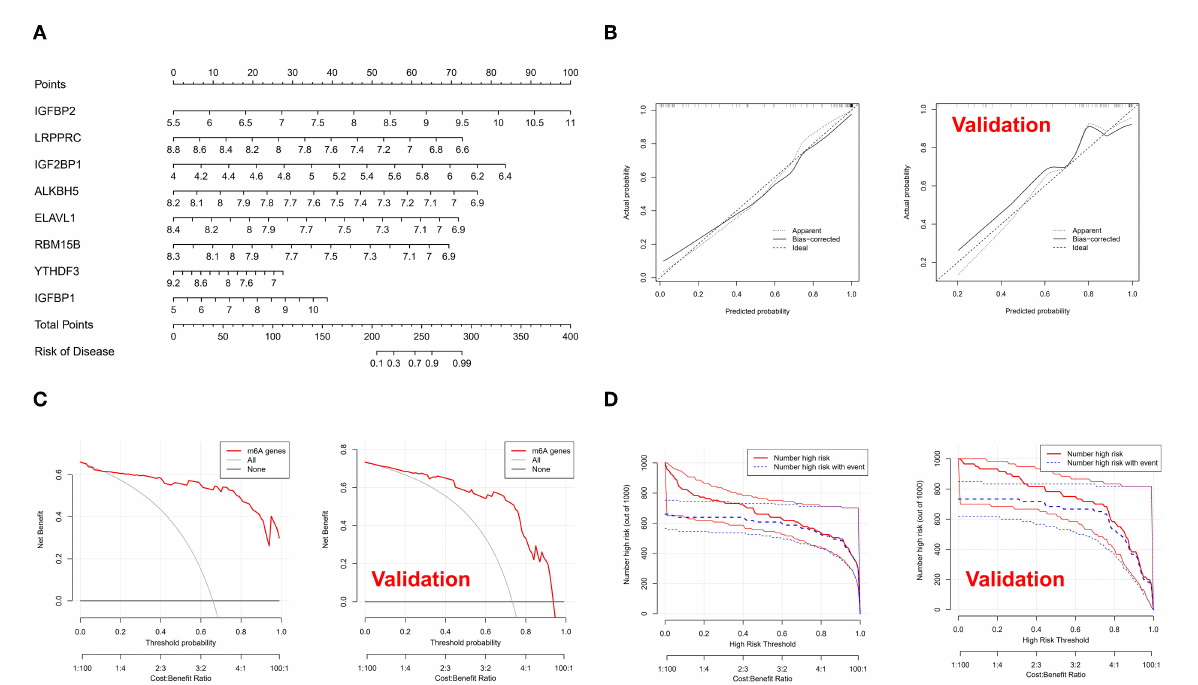
FIGURE3 (A) Nomograms for estimating the risk scores of eight m6A modulators associated with intracranial aneurysm (IA). Each parameter was assigned a score, and the sum was transformed to the least possible probability. (B) Calibration plots of the model concerning the agreement between anticipated and actual IA in the training and testing cohorts. On the X -axis, the nomogram-anticipated IA is displayed, whereas the actual IA is presented on the Y -axis. The diagonally dotted line denotes flawless calibration using an ideal model that exactly represents the observed outcomes. The solid line denotes the real performance of the nomogram; a tight alignment of the dotted and solid lines indicates a more accurate assessment of the true outcomes. Decision curves for two IA-specific risk predictive models (C) . On the vertical axis, the net advantage of standardization is depicted. The correlation between the risk criterion and the cost-benefit ratio is represented by the two horizontal axes. The clinical impact curves of the models are displayed in (D)